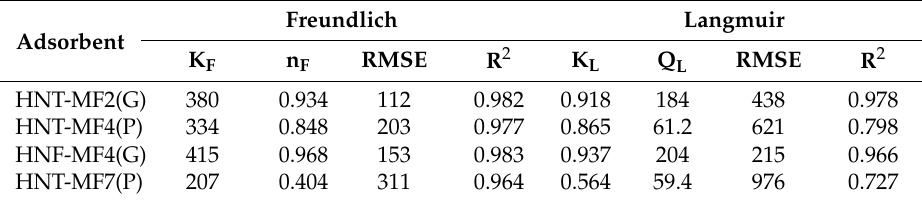
Figure 4. Adsorption isotherms of phosphate for adsorbents HNT-MF4 (P), HNT-MF2 (P), and HNT-MF7 (P). Table 3. Adsorption Freundlich and Langmuir isotherm data.